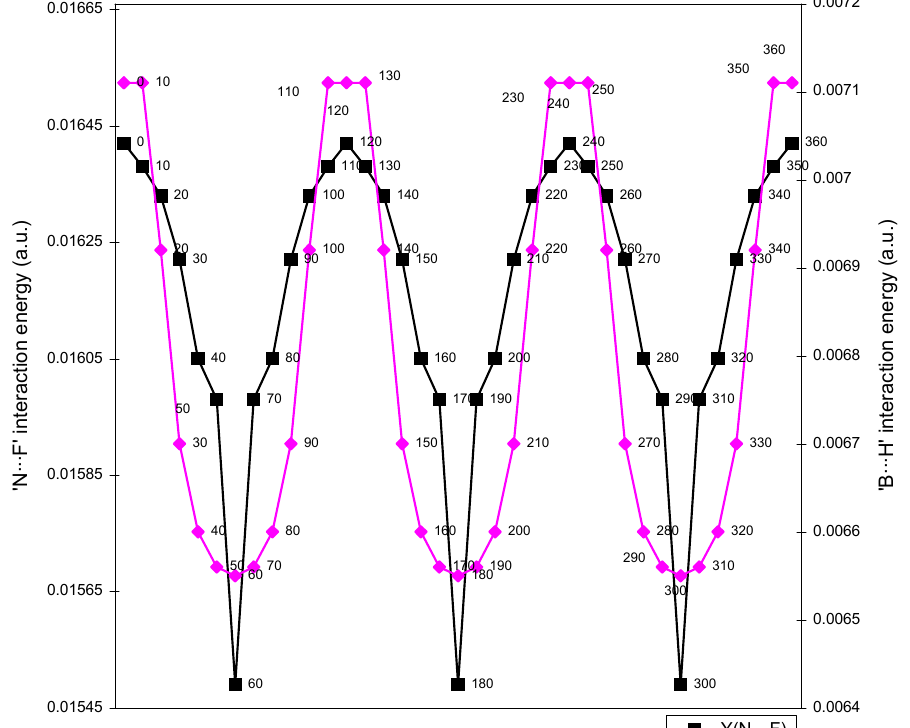
Figure 9. Plot of two-center non-bonded interaction energy of F function of torsional